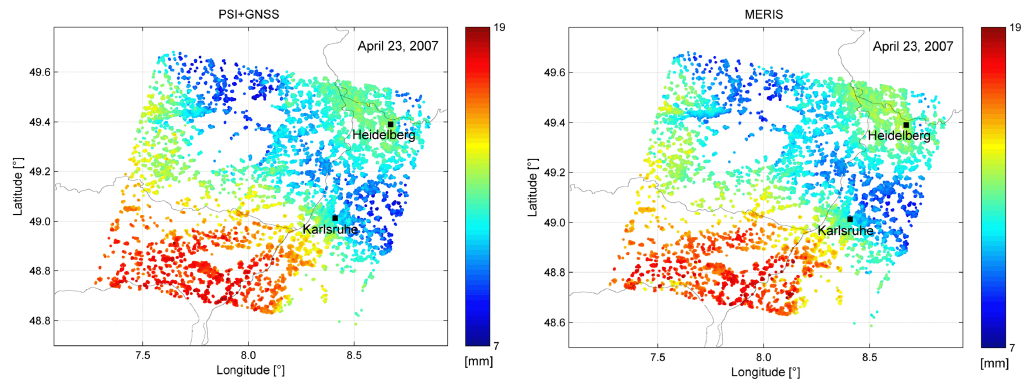
Figure 1. Maps of the absolute atmospheric PWV derived by combining PSI and GNSS data and the corresponding map from MERIS. The spatial correlation is 95% and the rms value of the differences is